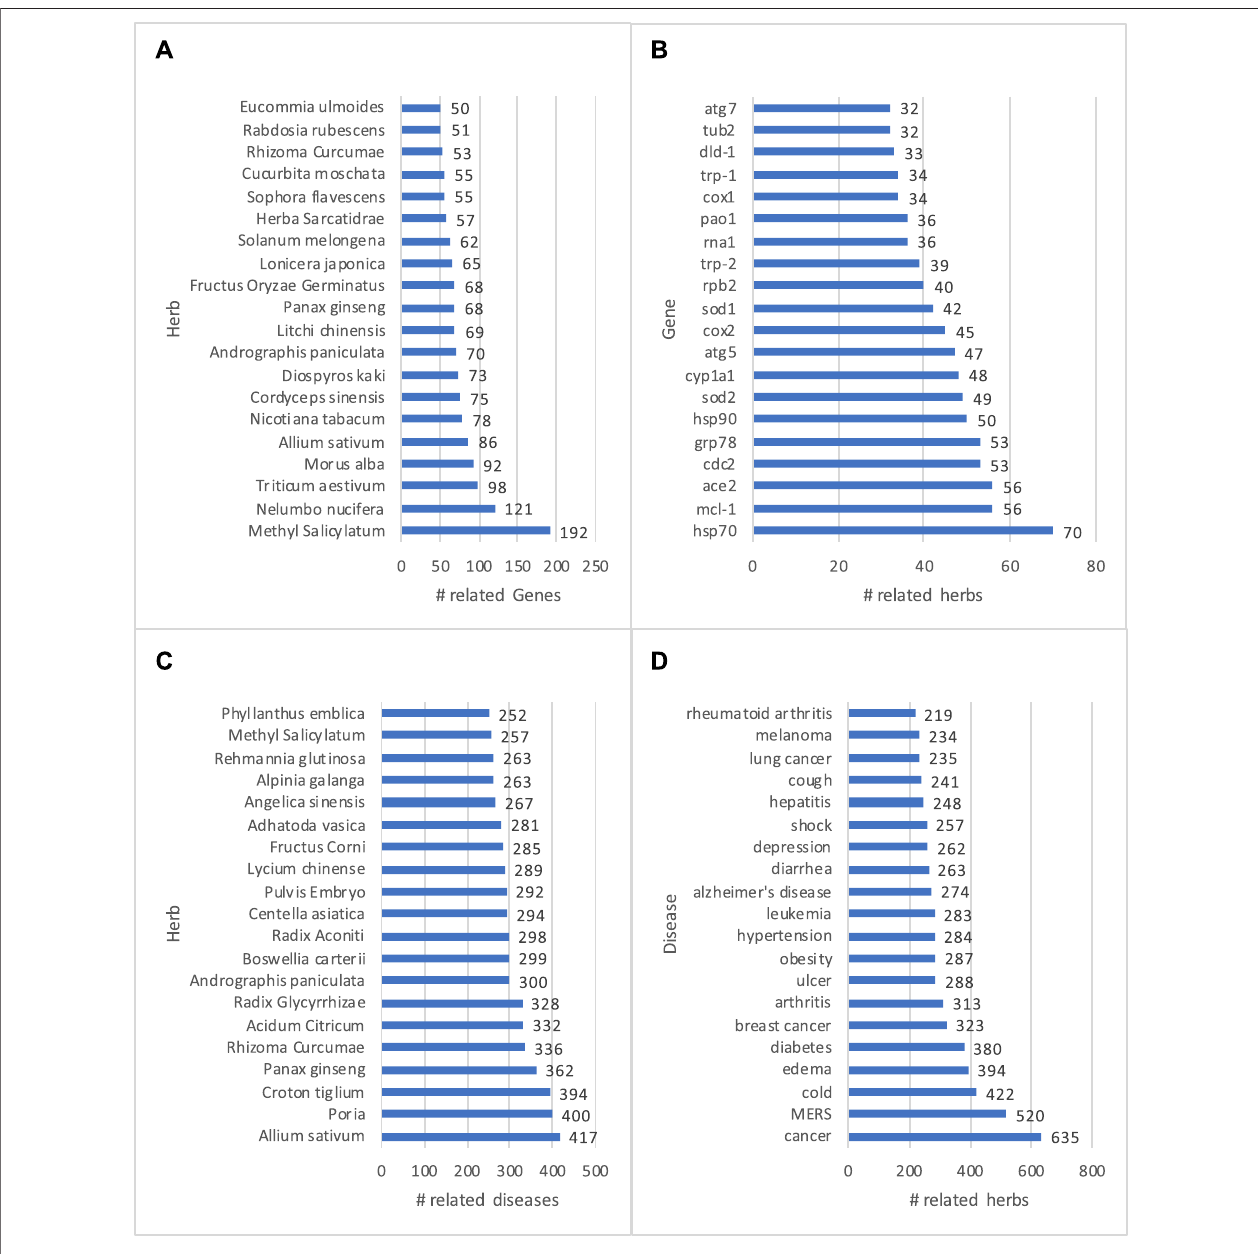
FIGURE 11 | Examples of descriptive analysis are shown. The HerbKG can provide the top-ranked herbs with the most related genes (A) , the genes regulated by the most herb extracts (B) , the herbs that can treat the most diseases (C) , and the most treated diseases by herbs (D) .